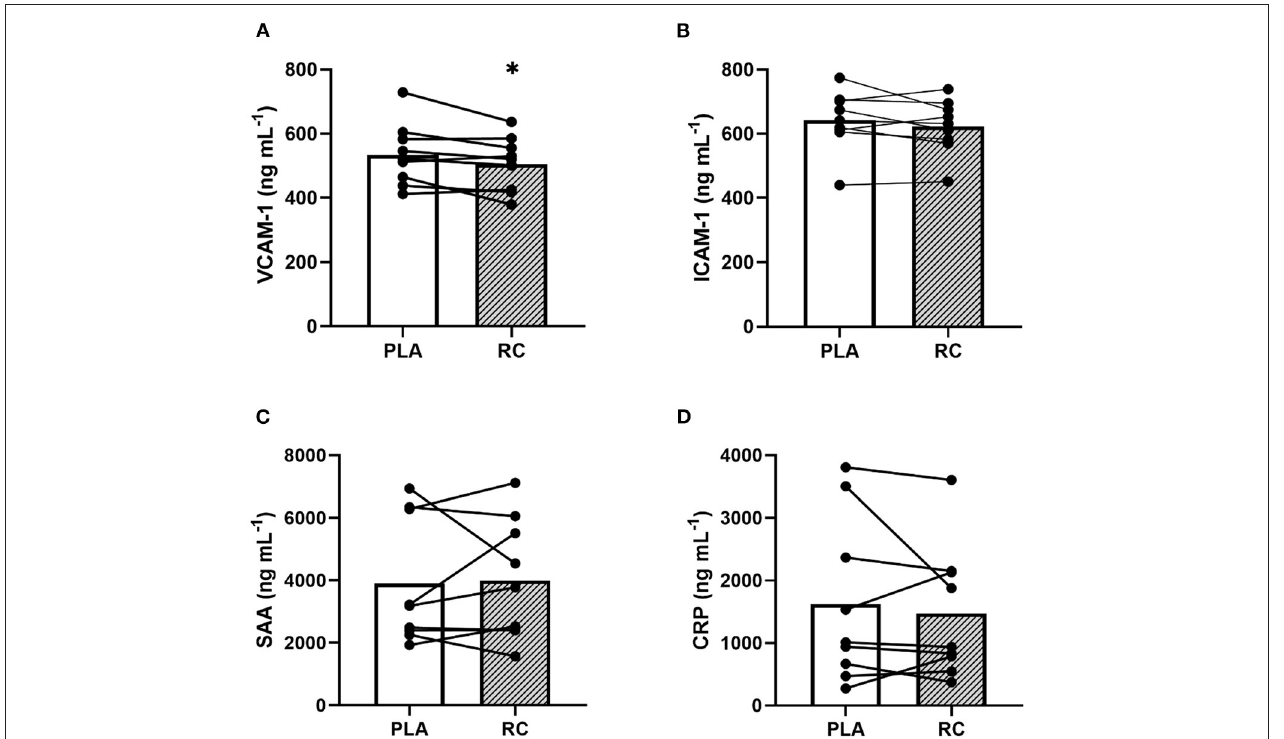
FIGURE 2 | Levels of inflammatory markers in plasma samples obtained from early post-menopausal women following two weeks of twice daily supplementation with placebo (PLA) or fermented red clover extract (RC) ( n = 9). (A) Vascular cell adhesion molecule 1 (VCAM-1), (B) intracellular adhesion molecule 1 (ICAM-1), (C) serum amyloid A (SAA), and (D) C reactive protein (CRP). *, indicates p < 0.05.